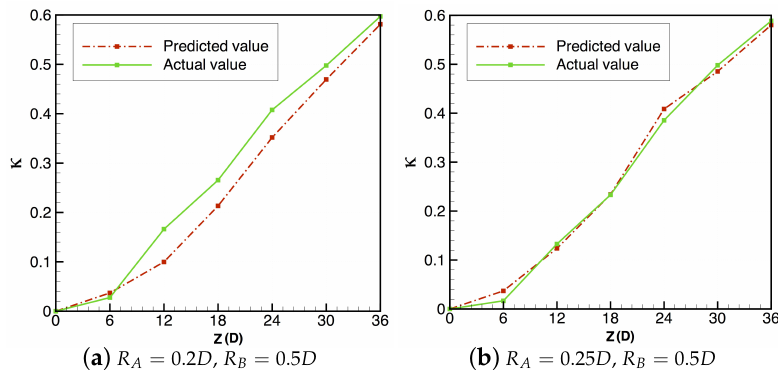
Figure 11. Relative entropy increase, κ , for combined geometries, showing evolution with axial location, and comparing idealised prediction with particle tracking in the actual velocity field. In both cases the error is small and the trend is predicted correctly. This prediction is more accurate for R A = 0.25 D and R B = 0.5 D , due to the fact that the change in the velocity fields is not as large as for R A = 0.2 D and R B = 0.5 D .